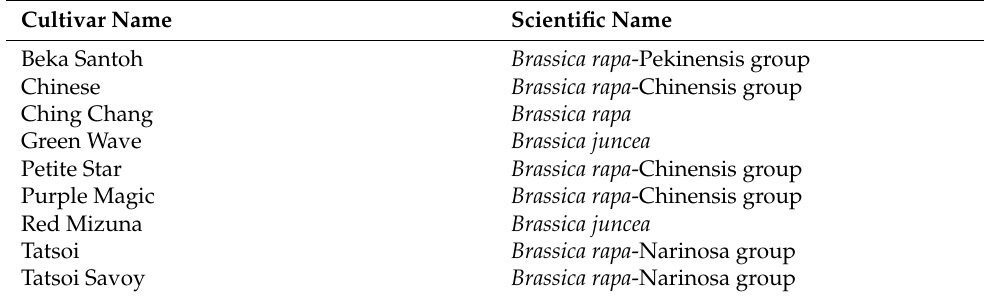
Table 1. List of cool-season leafy vegetables used in greenhouse trials in El Paso,